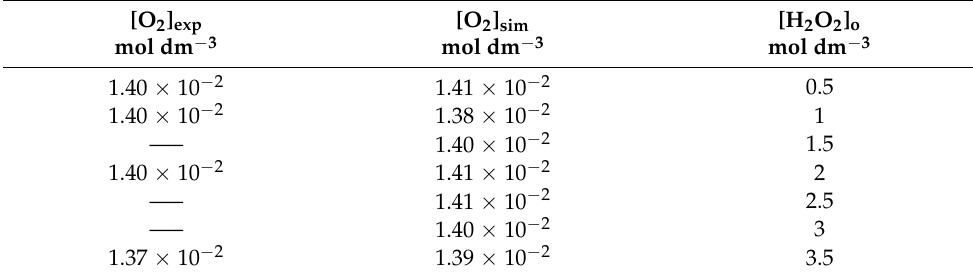
Figure 3. Simulated and experimental limiting values of [O 2 ], Simulated values (circles), experimental values (triangles). [H 2 O 2 ] o = 0.5, 1, 1.5, 2, 2.5, 3, 3.5 mol dm − 3 . Other parameters as in Figure 2. Table 1. Simulated and experimental values of [O 2 ] evolved in 5